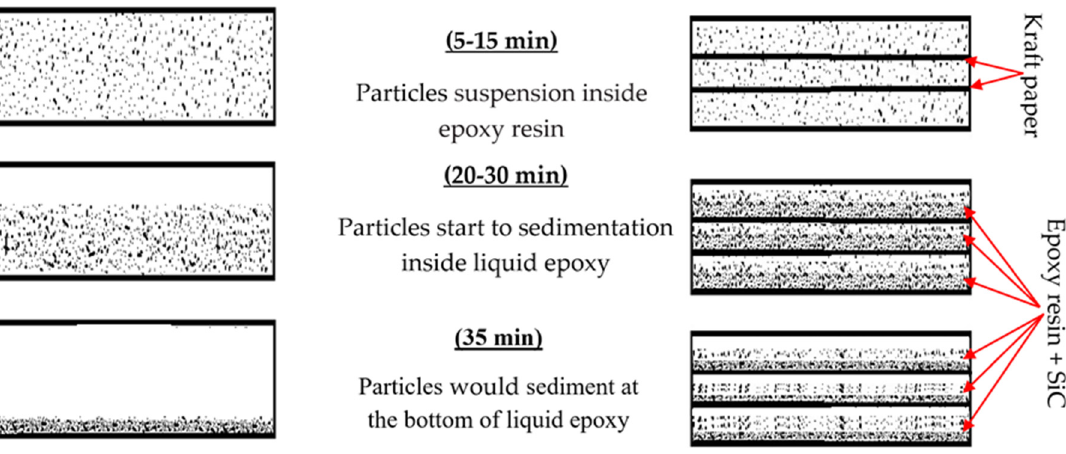
Figure 3. Schematic representing the effect of using kraft paper as separating layers in epoxy.